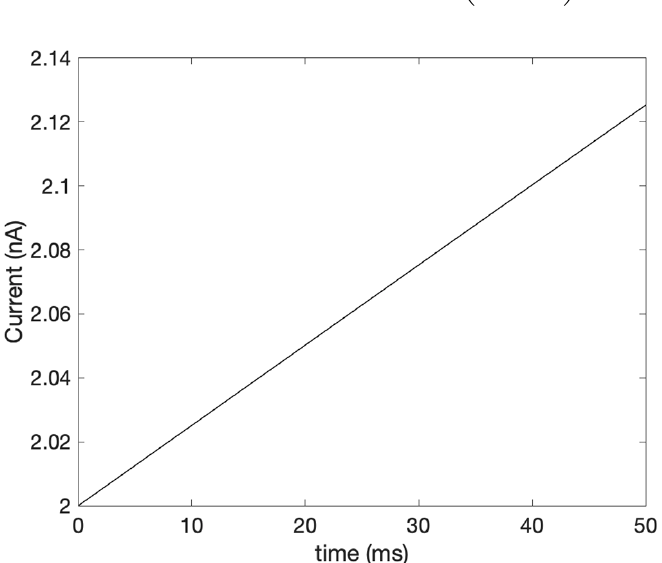
Figure 7. The varying input current .